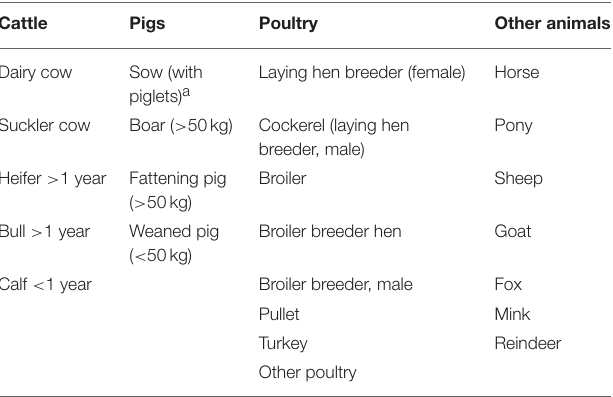
TABLE 1 | The main animal categories in the Finnish Normative Manure System and used in the emission inventories.